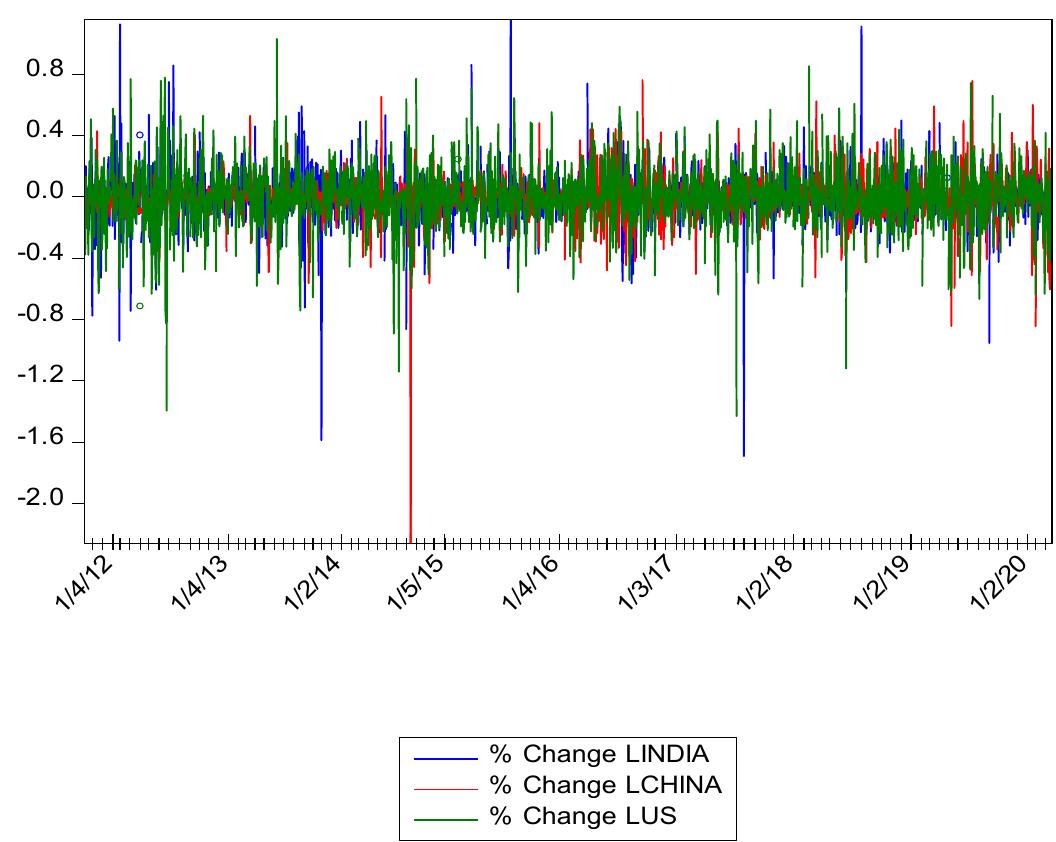
Figure 1. Natural Logarithms of Cotton futures price series in MCX Futures India, ICE Futures U.S., and Zhengzhou Com- modity Exchange China.